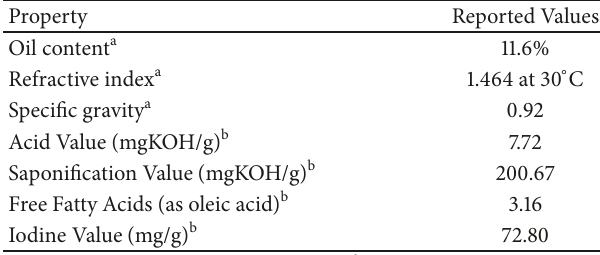
Table 1: Physical and Chemical Properties of the Extracted Chryso- phyllum albidum seed